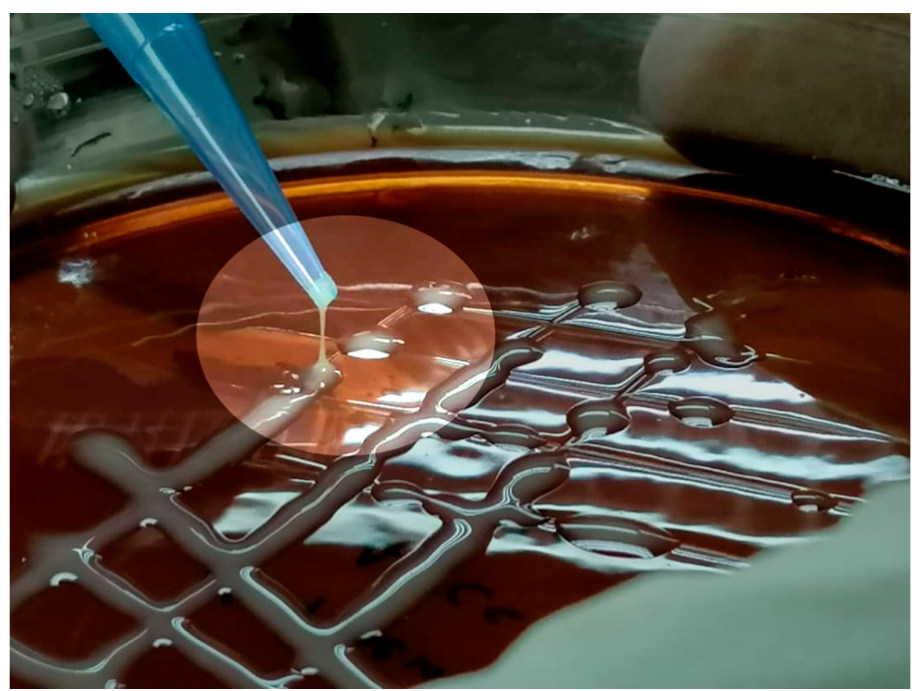
Figure 6. PCR confirmation results of the biochemically confirmed bacterial colonies.